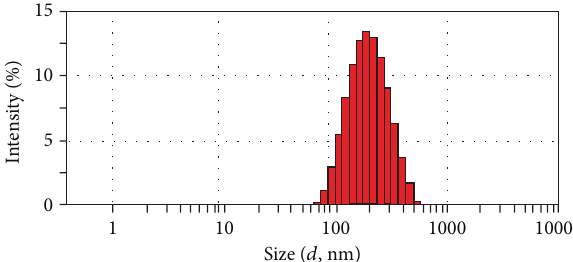
Figure 3: Size distribution of sinomenine cubosome.